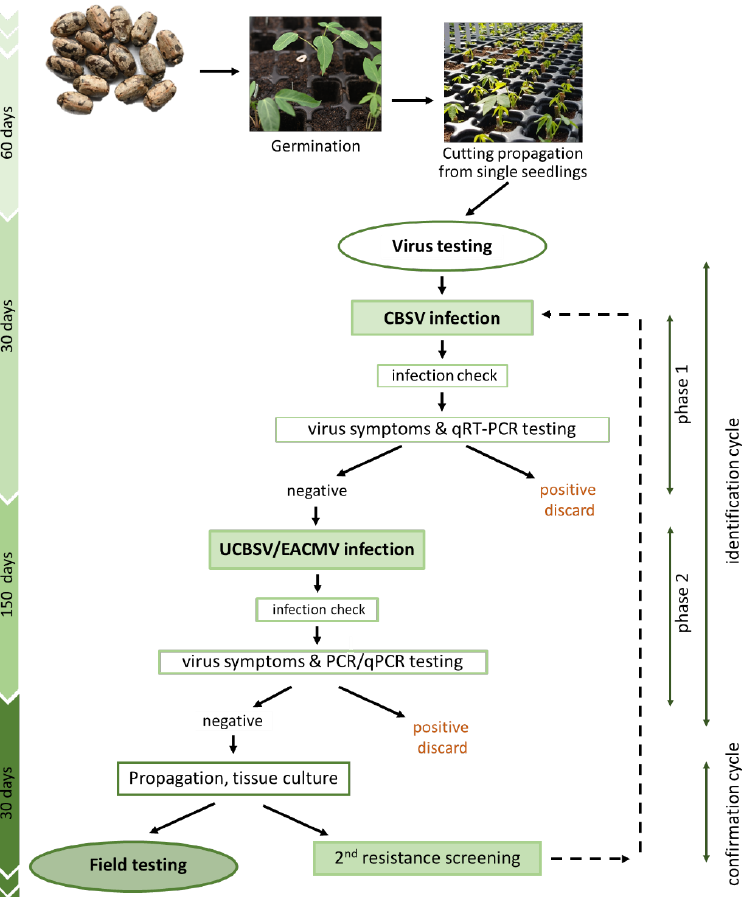
Figure 3. Testing for U/CBSV and EACMV virus resistance in cassava seedling families. The confirmation cycle consists of a further laboratory screening phase and parallel field testing to reduce evaluation time.